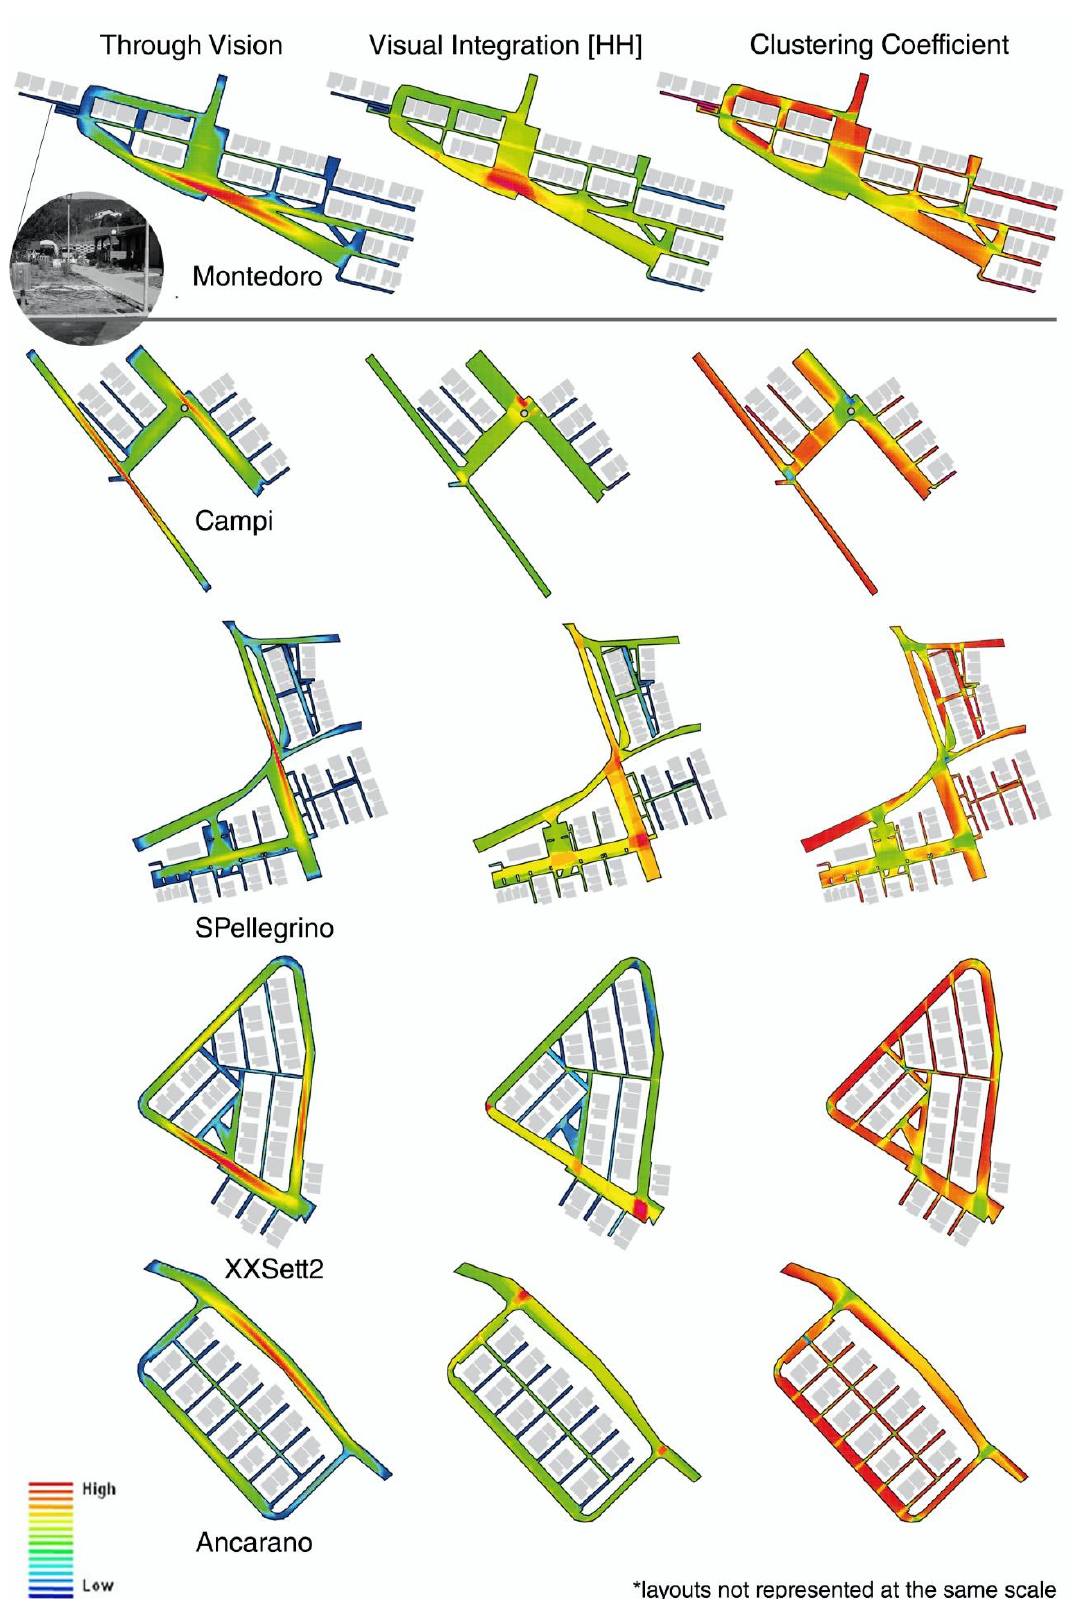
Figure 11 VGA Through Vision, Visual Integration, Clustering Coefficient of the TH sites in Clusters 1 and 3, which have been assigned a future residential